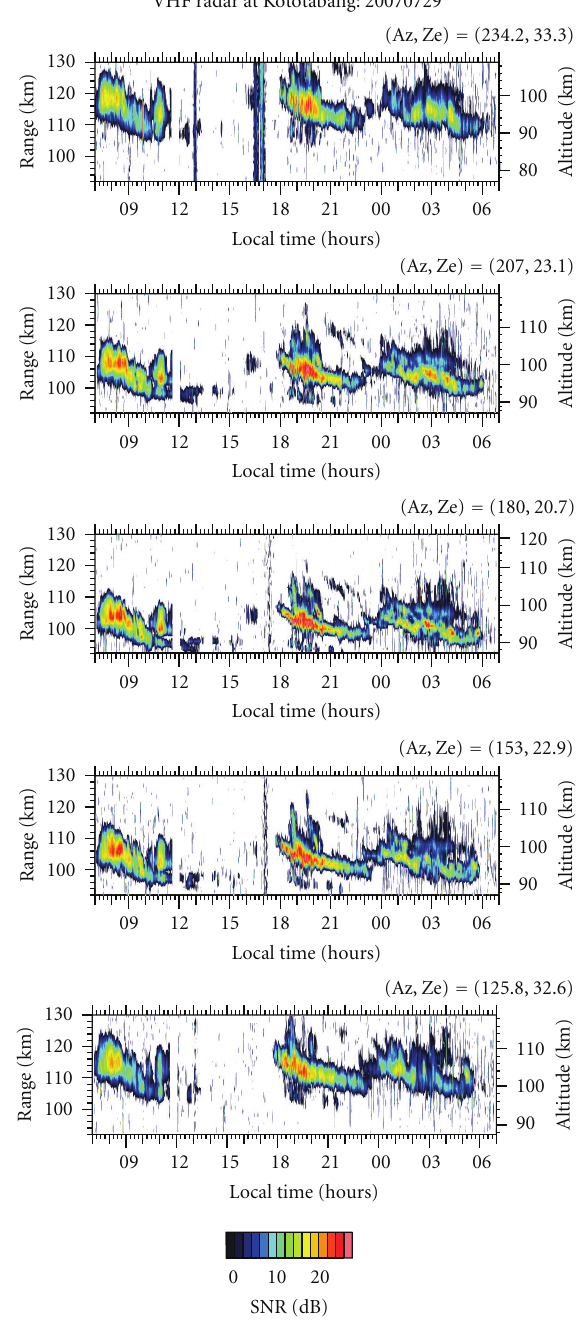
Figure 1: Range-time-SNR plot of the E -region Field-Aligned Irregularity (FAI) observed on beams with azimuth 125.8 ◦ , 153.0 ◦ , 180.0 ◦ , 207.0 ◦ and 234.2 ◦ (top to bottom panels) with the 30.8MHz radar at Kototabang, Indonesia on July 29, 2007. Left vertical axis shows the range from the radar and the right axis shows the altitude at which the radar beam is perpendicular to the geomagnetic